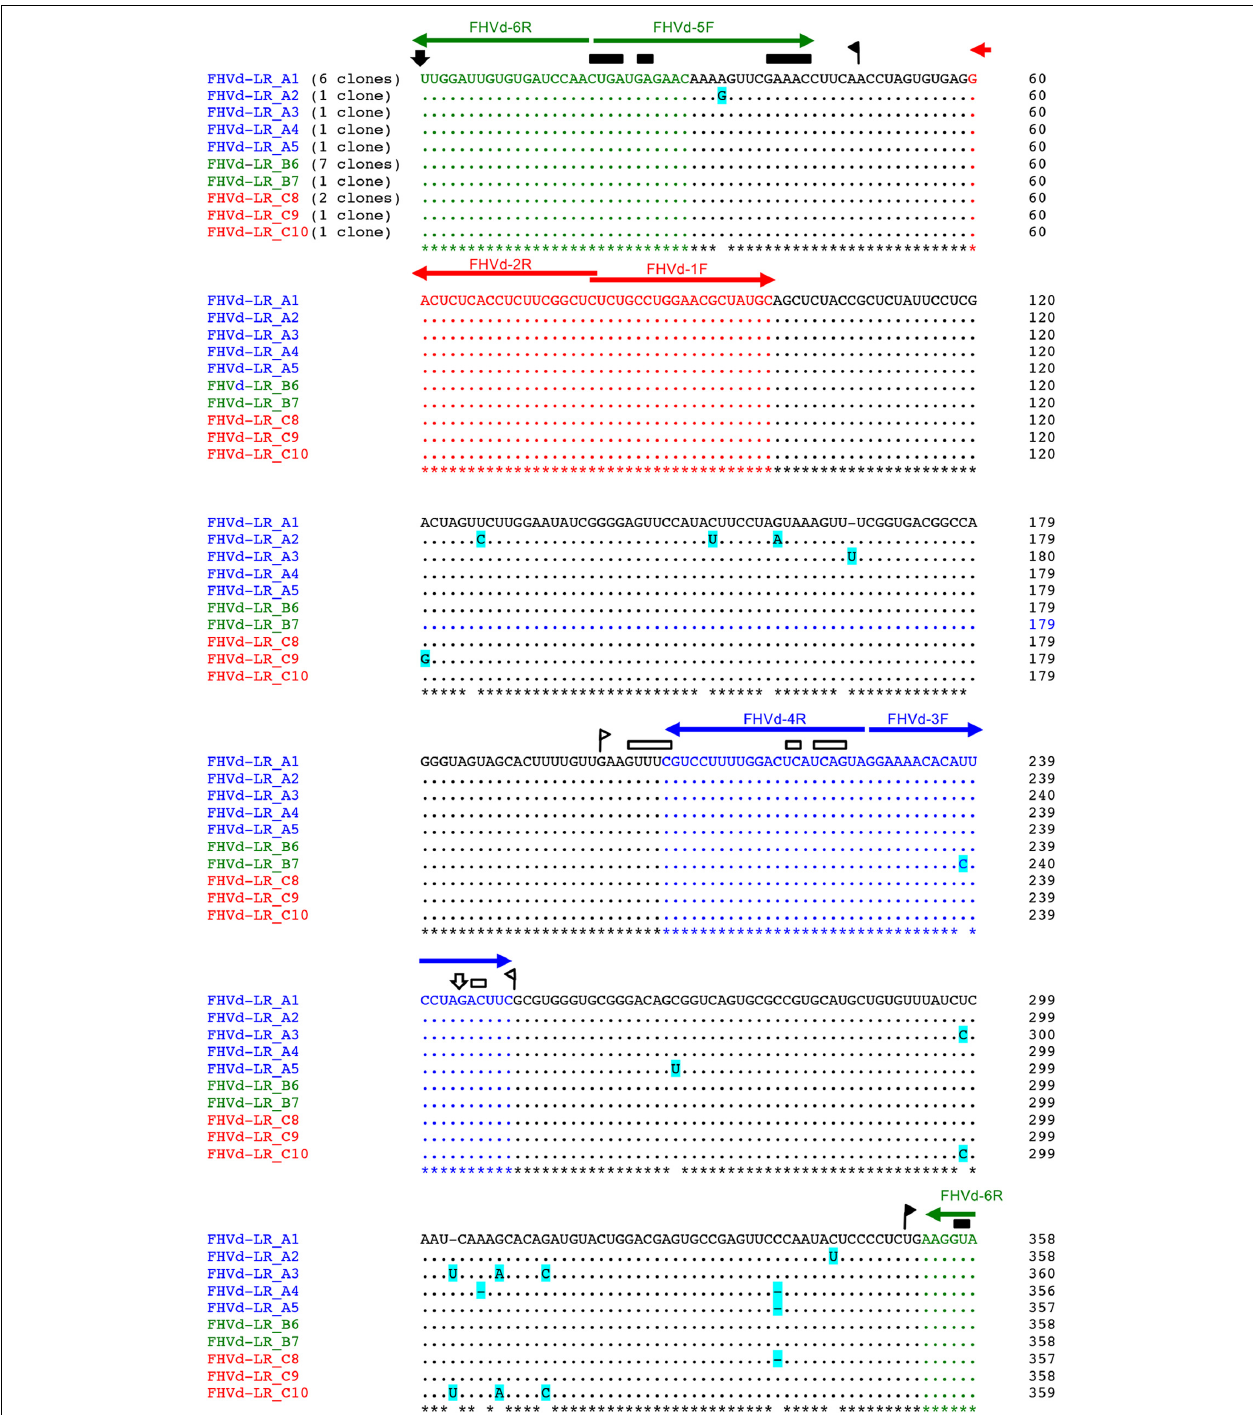
FIGURE 1 | Multiple-sequence alignment of full-length cDNAs of fig hammerhead viroid-like RNA (FHVd-LR) variants amplified with primer pairs FHVd-1F/2R (in red), FHVd-3F/4R (in blue), and FHVd-5F/6R (in green). Names of the sequence variants and primers (horizontal arrows) used to amplify the corresponding cDNAs are reported with the same colors; the numbers of clones containing the same variant are indicated in brackets. The reference variant (FHVd-LR_A1) reported at the top is identical to the variant FHVd-LR_B6 and, being the most frequently sequenced (found in 13 independent clones), also corresponds to the master sequence in the population. Nucleotide identity and gaps with respect to the FHVd-LR_A1 variant are indicated by dots and dashes, respectively. The light blue background highlights mutations. Regions involved in the formation of ( + ) and ( − ) hammerhead structures are delimited by flags; arrows and bars indicate the self-cleavage sites and the nucleotides conserved in most natural hammerhead structures, respectively; filled (black) and open symbols refer to ( + ) and ( − ) polarity, respectively. Nucleotide positions in the multiple alignments are reported on the left.